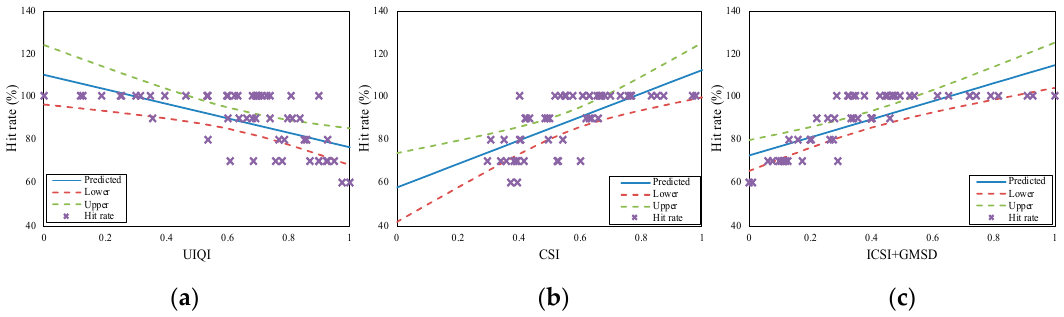
Figure 3. The correlations of the ( a ) camouflage similarity index (CSI), ( b ) universal image quality index (UIQI) and ( c ) image color similarity index and gradient magnitude similarity deviation (ICSI + GMSD) for hit rate.